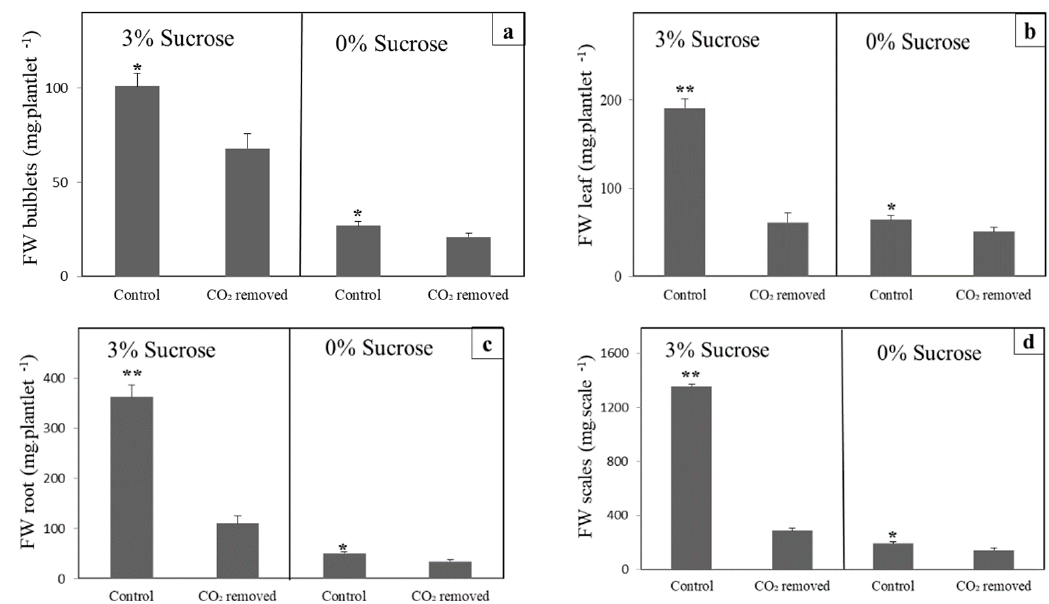
Figure 2. Effect of CO 2 removal on lily growth: bulblets ( a ), leaves ( b ), roots ( c ), and scale explants ( d ) in medium with 3% sucrose or without sucrose. *, p ≤ 0.05 and **, p ≤